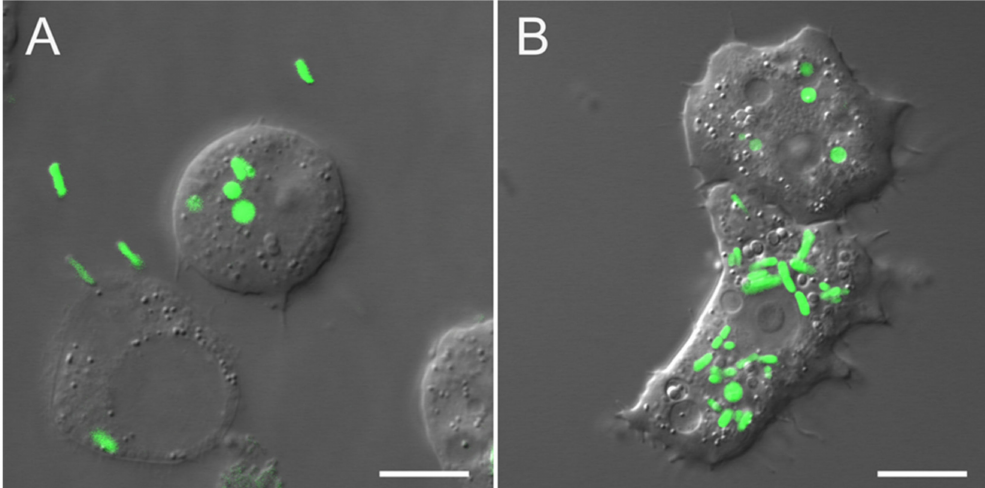
Figure 5. Acanthamoeba castellanii infected with S. Typhimurium (GFP) before ( A ) and after ( B ) washing procedures. Confocal laser scanning microscopy: differential interference contrast overlays with single optical GFP fluorescence sections in the green channel. Scale bars: 10 µ